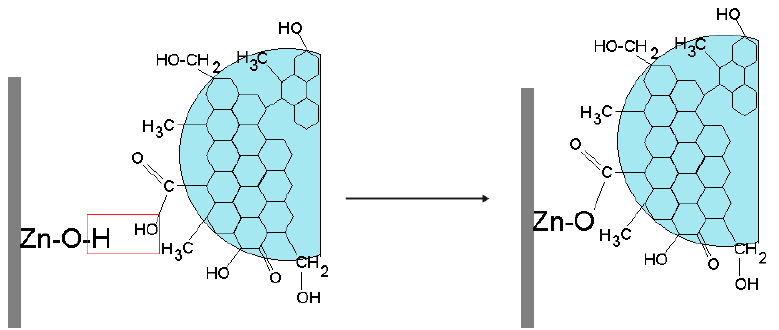
Figure 9. Schematically representation of the esterification reaction between the carboxyl groups from CQDs and the hydroxyls groups from ZnO.